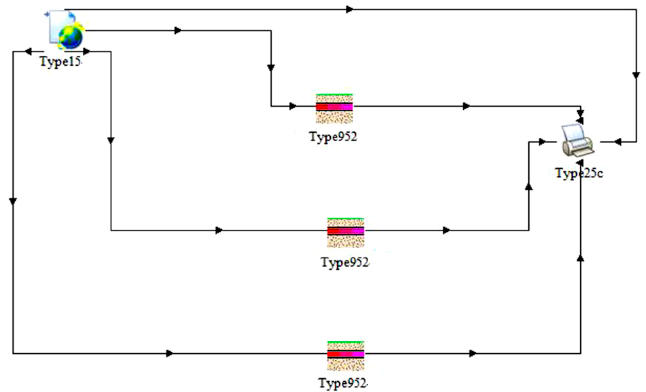
Figure 2. TRNSYS model of HAGHE.